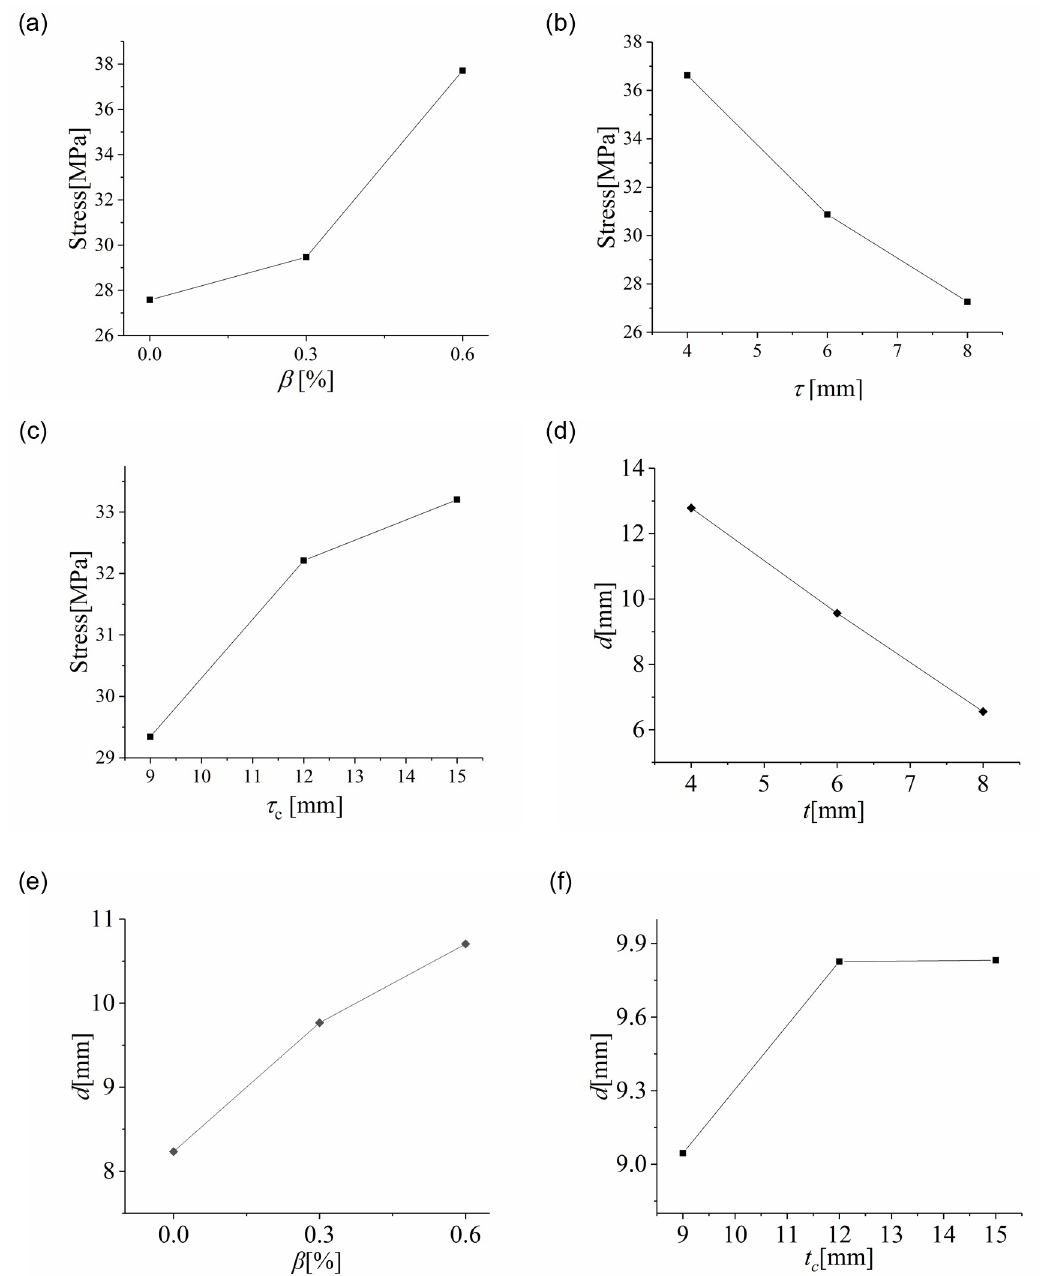
Fig 10. Influence curves of. (a) cold-bent torsion rate, (b) glass thickness, (c) cavity thickness on the plate center stress; (d) cold- bent torsion rate, (e) glass thickness, (f) cavity thickness on the plate center deflection.